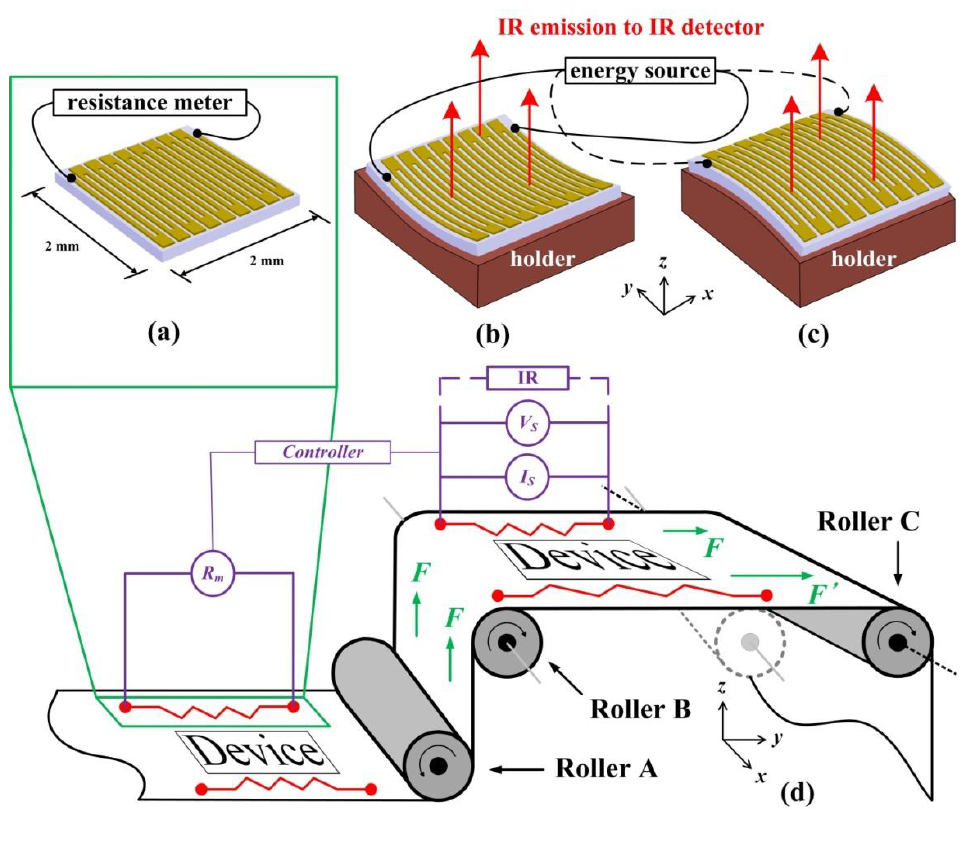
Figure 2. ( a ) The proposed strain sensor consists of a serpentine Au resistor on the polyethylenenaphthalate (PEN) substrate with a voltage or a current source. The detection demonstration system has an infrared (IR) detector above the ( b ) concave and ( c ) convex holder underneath the strain sensor to measure the compression and the tension cases, respectively. ( d ) The roll-to-roll manufacturing process with the proposed method. A side-to-side balanced force ( F and F' ) on the roll becomes unbalanced ( F and F' ) with an off-axis roller (Roller C). The roller in ( d ) in dashed line is the correct and expected location for the Roller C. Extra resistance meter ( R ) and controllers help to adjust the m voltage source ( V ) and current source ( I ) to eliminate initial resistance s s